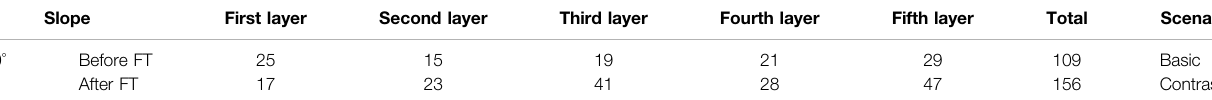
TABLE 2 | Denudation amount.